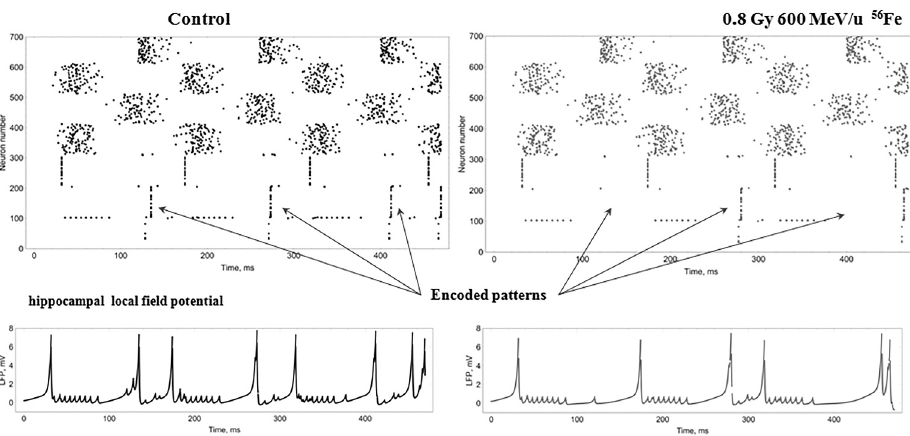
Figure 3. Neural network activity in normal conditions (left) and after 1 month of 0.8 Gy 600 MeV / u iron ion irradiation (right). Cue patterns modulating theta-rhythm (neurons numbers from 300 to 700) result in synchronized spiking activity of hippocampal neurons (0-300) on rasterogramms. Voltage traces corresponding to the hippocampal local field potential are presented at the bottom of the picture. After irradiation two of three possible patterns in DG granule cells (neurons 0-100) and CA3 pyramidal cells (neurons 100-200) are lost